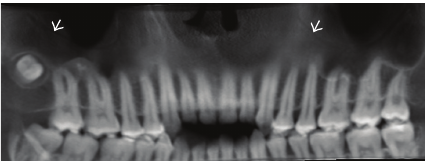
Figure 3: Panoramic radiograph of the bony canal pathway (white arrows).